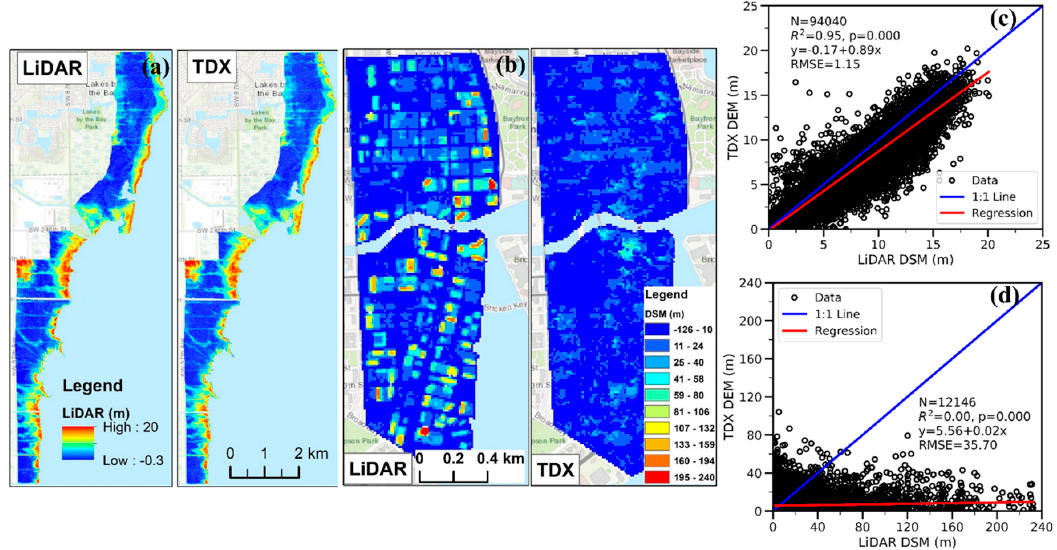
Figure 8. (a) LiDAR DSM and TDX DEM for the mangrove forest area along the east coast of